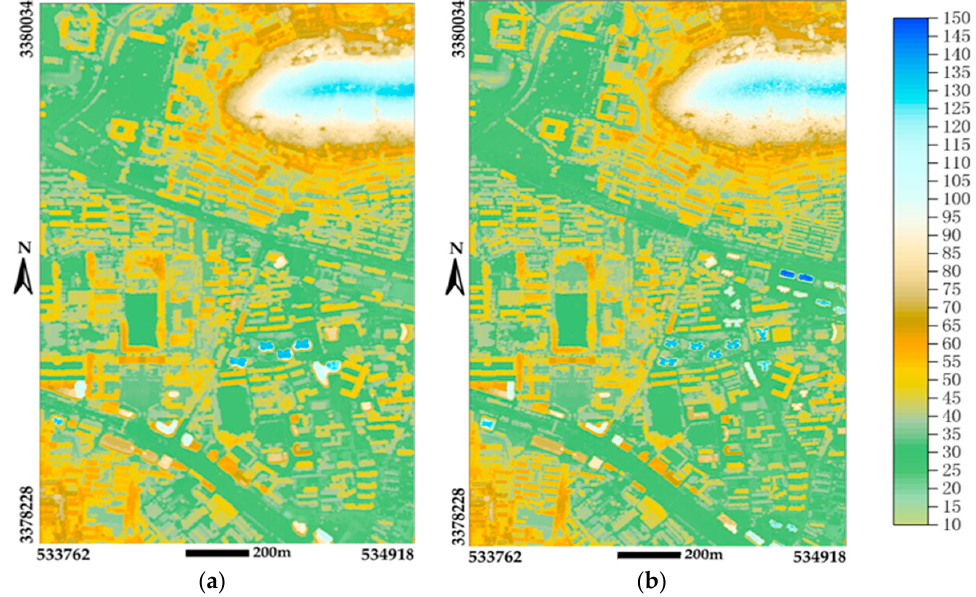
Figure 10. DSM interpolation result: ( a ) DSMold; and ( b ) DSMnew.